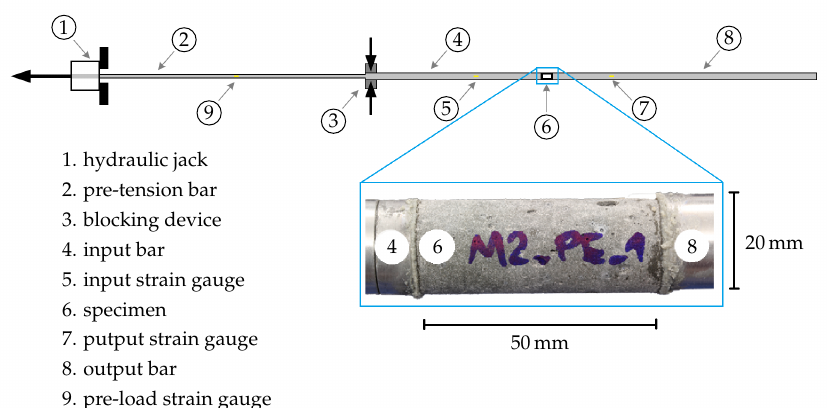
Figure 5. Split Hopkinson tension bar setup, based on [5,27].